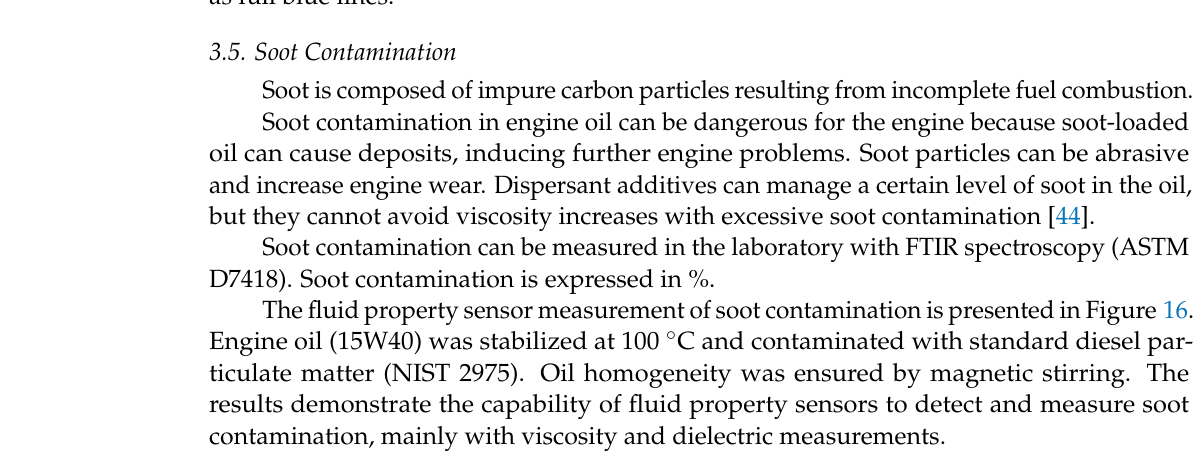
(39) These models are plotted in Figure 16 with the related accuracy specifications given as full blue lines. 3.6. Metal Contamination Metal contamination comes from wear induced by bad lubrication and from corro- sion. The main metals to be monitored are Fe, Cu, or Al, which are components of the main engine parts. Metal contamination is dangerous because it can accelerate oil degradation. Metal contamination is, above all, a sign of abnormal wear. Metal contamination can be measured in the laboratory with ICP spectrometric anal- ysis (NFT 60 106). Metal contamination is expressed in mg/kg, equivalent to ppm mass [45]. Iron (Fe) contamination measurements are presented in Figure 17. Engine oil (15W40) was stabilized at 100 °C and contaminated with <10 µm Fe particles up to 105 ppm in mass. Oil homogeneity was ensured by magnetic stirring. The results demonstrate the capability of the fluid property sensor to detect and measure extremely high levels of Fe contamination with viscosity, density and dielectric measurements.